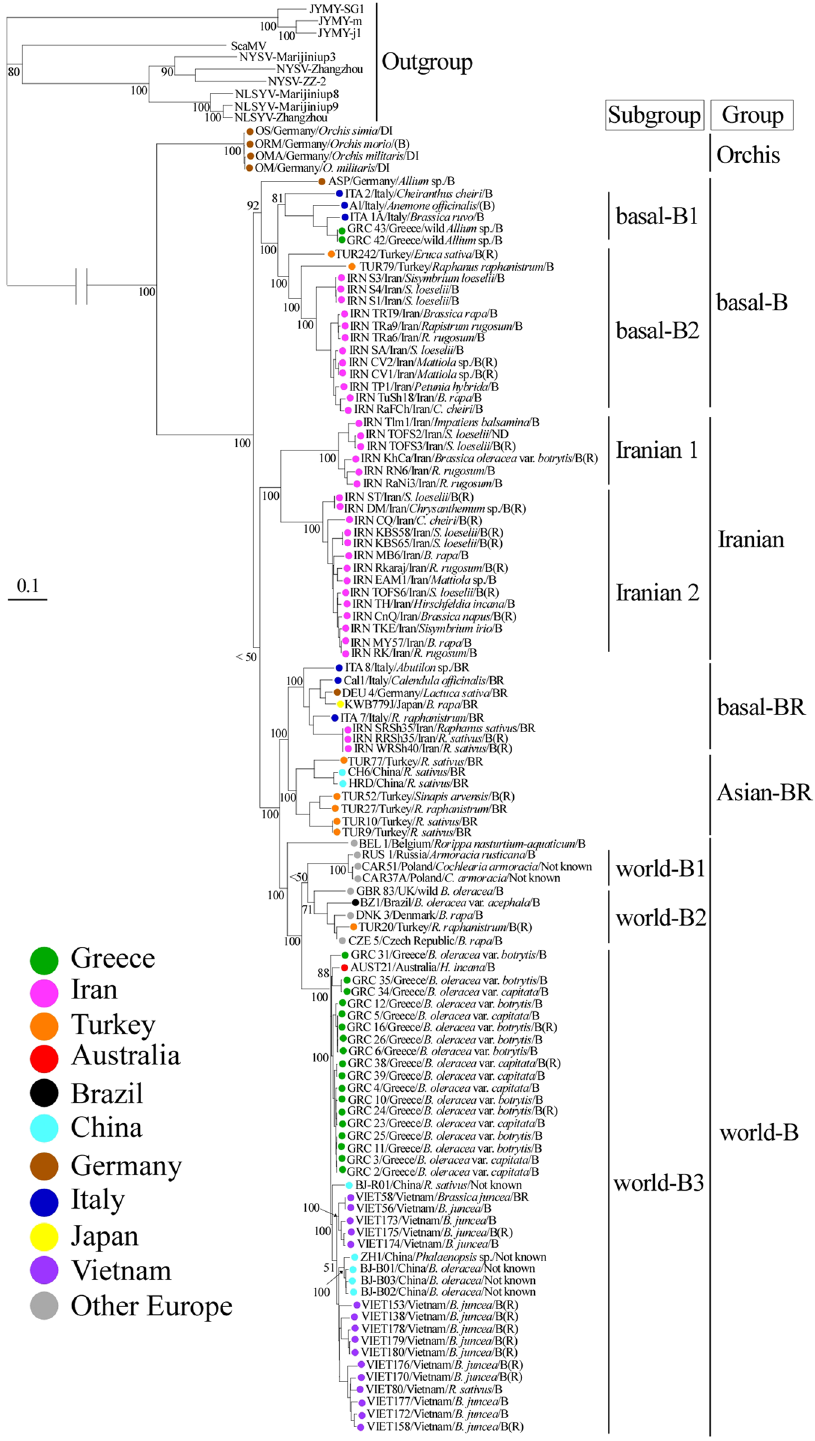
Figure 3. Maximum-likelihood tree inferred from the major open reading fame sequences of turnip mosaic virus. Only non-recombinant sequences were used. Numbers at each node indicate bootstrap percentages based on 1000 pseudoreplicates. The scale bar indicates 0.1 substitutions per site. The genomic sequence of the isolates of narcissus late season yellows virus (NLSYV), narcissus yellow stripe virus (NYSV), Japanese yam mosaic virus (JYMV), and scallion mosaic virus (ScaMV) were used as outgroup taxa. Details of the isolates are given in Supplementary Table